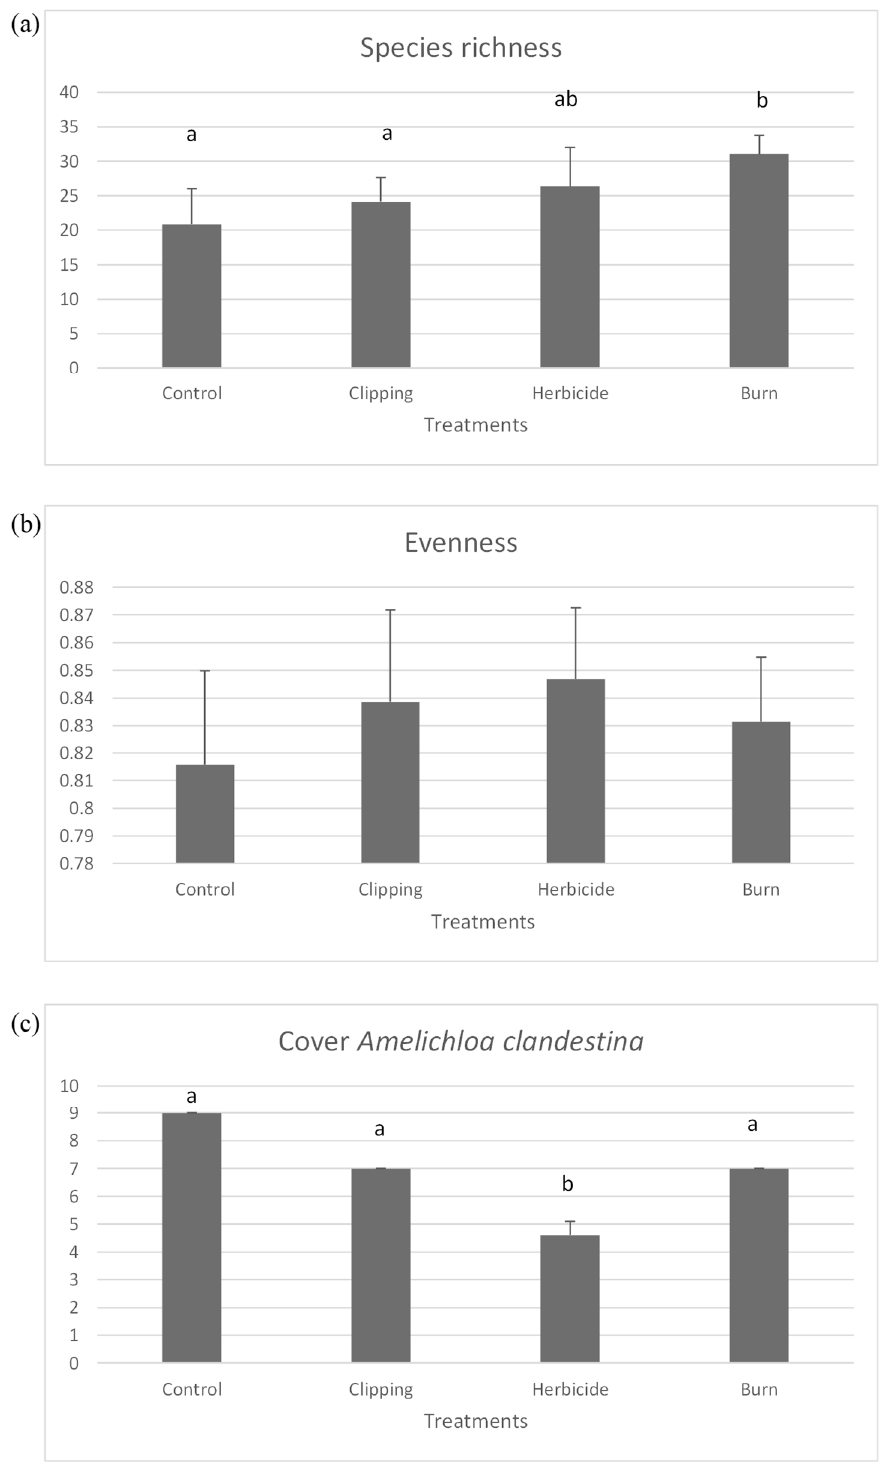
Figure 4. Mean values and standard deviations for ( a ) species richness, ( b ) evenness, and ( c ) cover of Amelichloa clandestina for the different treatments. Identical letters on top of bars indicate non- significant differences ( p < 0.05 for d.f. = 23 for the error term).